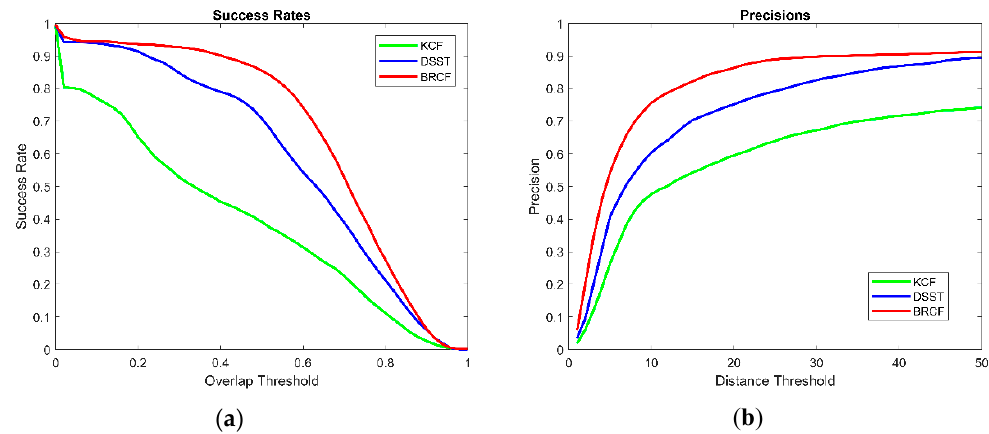
Figure 11. The performances of KCF, DSST, and BRCF on all video sequences: ( a ) The curve of success rate over the overlap ratio threshold; ( b ) The curve of precision over distance threshold. The success rate is the ratio of the number of successful frames to the total number of frames in all video sequences. Distance is calculated by the Euclidean distance between the center pixels of two bounding boxes.